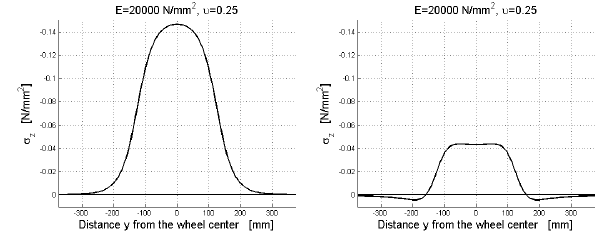
Figure 15: Profiles of σ z on the A-A vertical cross-section of Figure 11 for z = − 75 mm: Boussinesq’s solution on the left and the second order solution on the right.